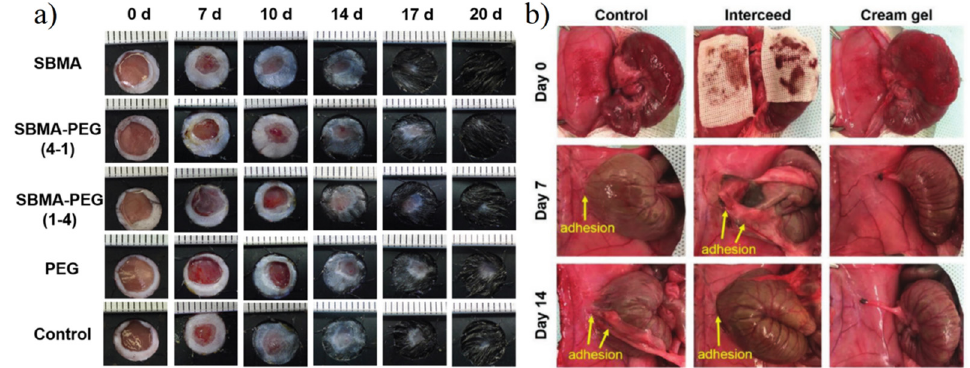
Figure 21. Typical wound healing effects of the zwitterionic hydrogel. ( a ) Wound healing performance of zwitterionic hydrogel applied on healthy mice with back circumcision. Zwitterionic hydrogel showed both a much faster recovery rate and better hair growth. Reproduced with permission from [167]. Copyright 2018 Elsevier Ltd. ( b ) PCBAA cream-gel with biodegradable BAC crosslinker for peritoneal adhesion. On days 7 and 14 post-surgery, adhesions were observed in the untreated control and intercede film groups, while no adhesion was observed in rats treated with cream-gel. Reproduced with permission from [171]. Copyright 2020 Wiley-VCH GmbH.